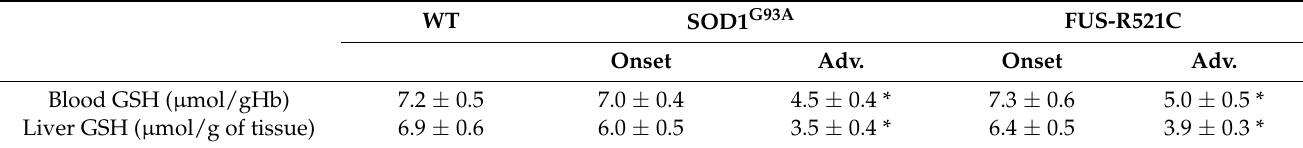
Table 2. Blood and liver GSH in wild-type and ALS mice. Blood and liver samples were obtained and treated as described in Methods. Data are means ± SD for 10–12 different mice. * p < 0.01 comparing values obtained in ALS mice versus wild-type